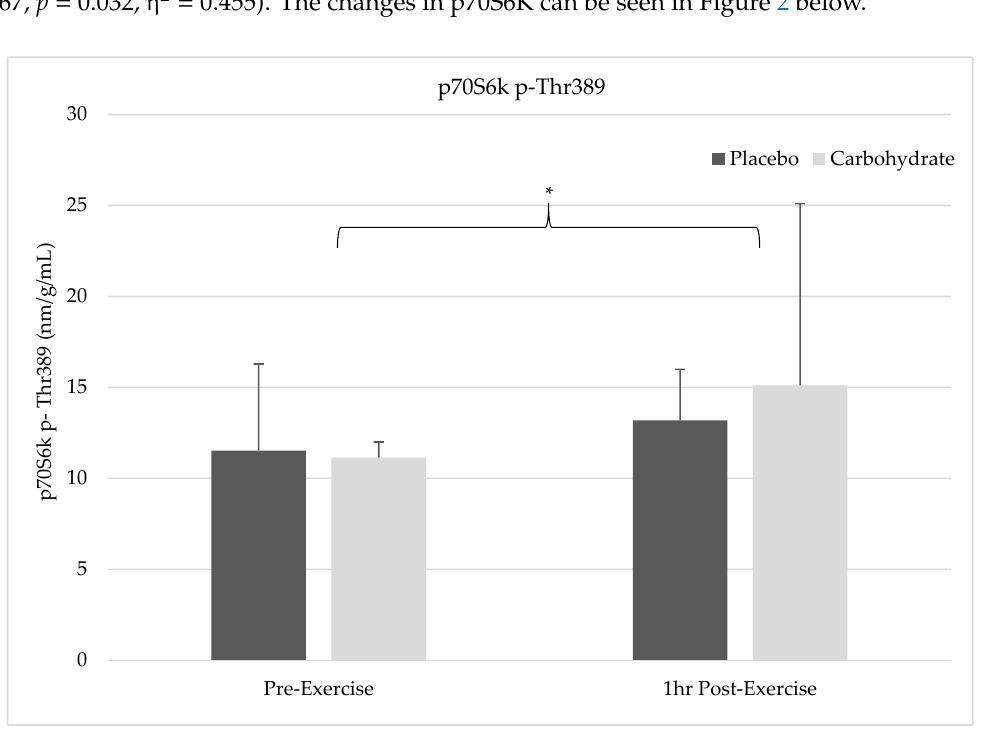
Figure 2. Changes in total amount of ribosomal protein S6 kinase beta-1 (p70S6K) phosphorylated at